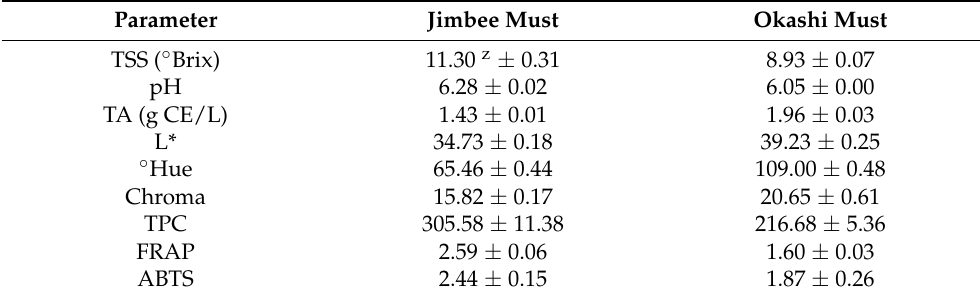
Table 2. Physicochemical parameters of the Jimbee and Okashi melon